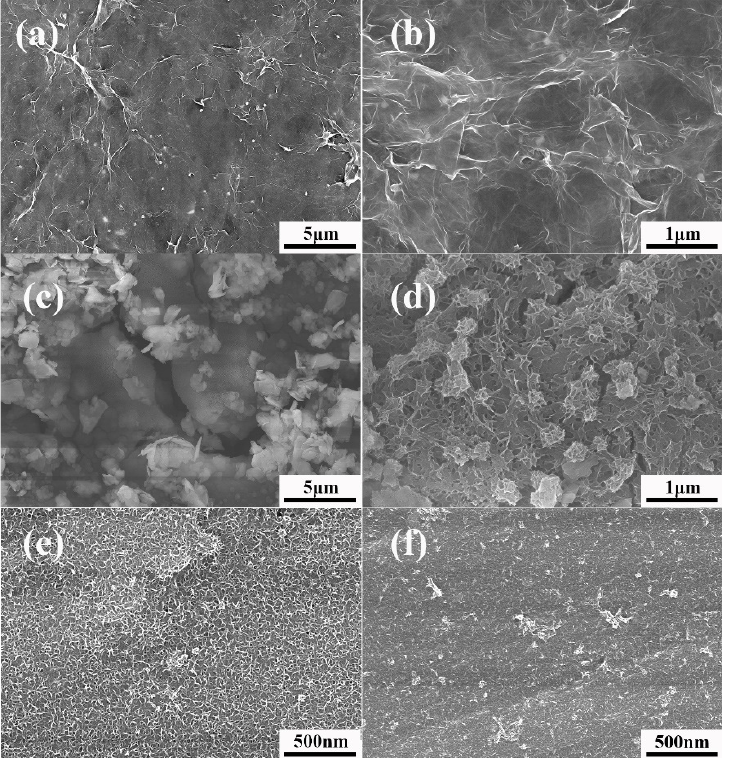
Figure 2. SEM images of films deposited on AZ31B: ( a , b ) TiO 2 , ( c , d ) MoS 2 , ( e ) TiO 2 /MoS 2 , ( f ) TiO 2 /MoS 2 -K. ( f ) TiO 2 /MoS 2